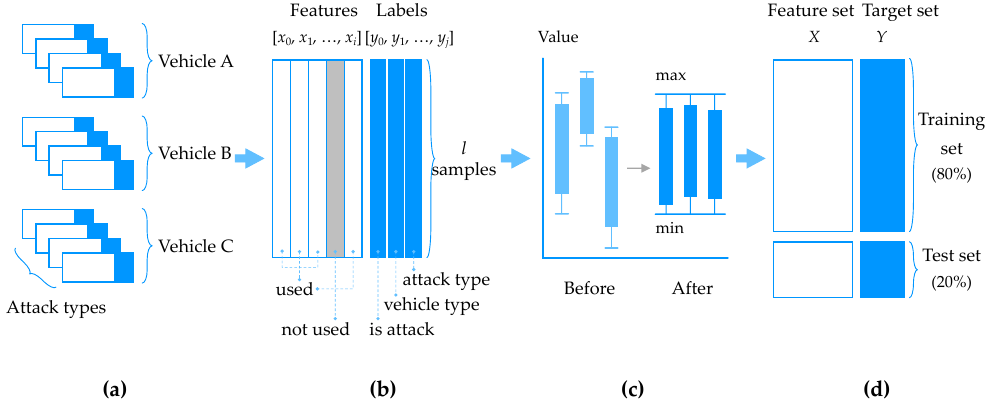
Figure 4. MLHC data preprocessing: ( a ) initial dataset; ( b ) merging and feature selection; ( c ) scaling; and ( d ) data